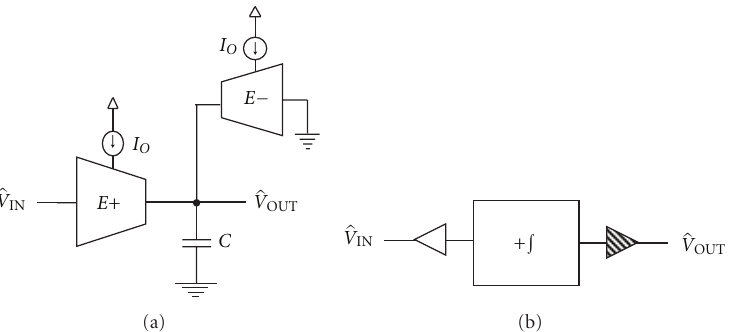
Figure 3: (a) Lossless DC stabilized log-domain noninverting integrator. (b) The employed symbol.